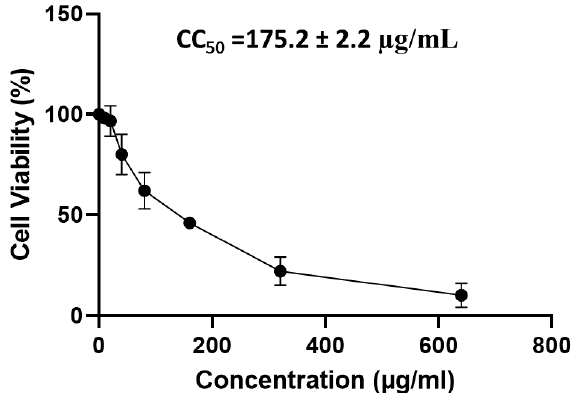
Figure 2. A graph showing the cytotoxicity of APEE on Vero-E6 cells using MTT assay to determine CC 50 . The results are expressed as mean ± SD as the experiments were performed in three independent triplicates.